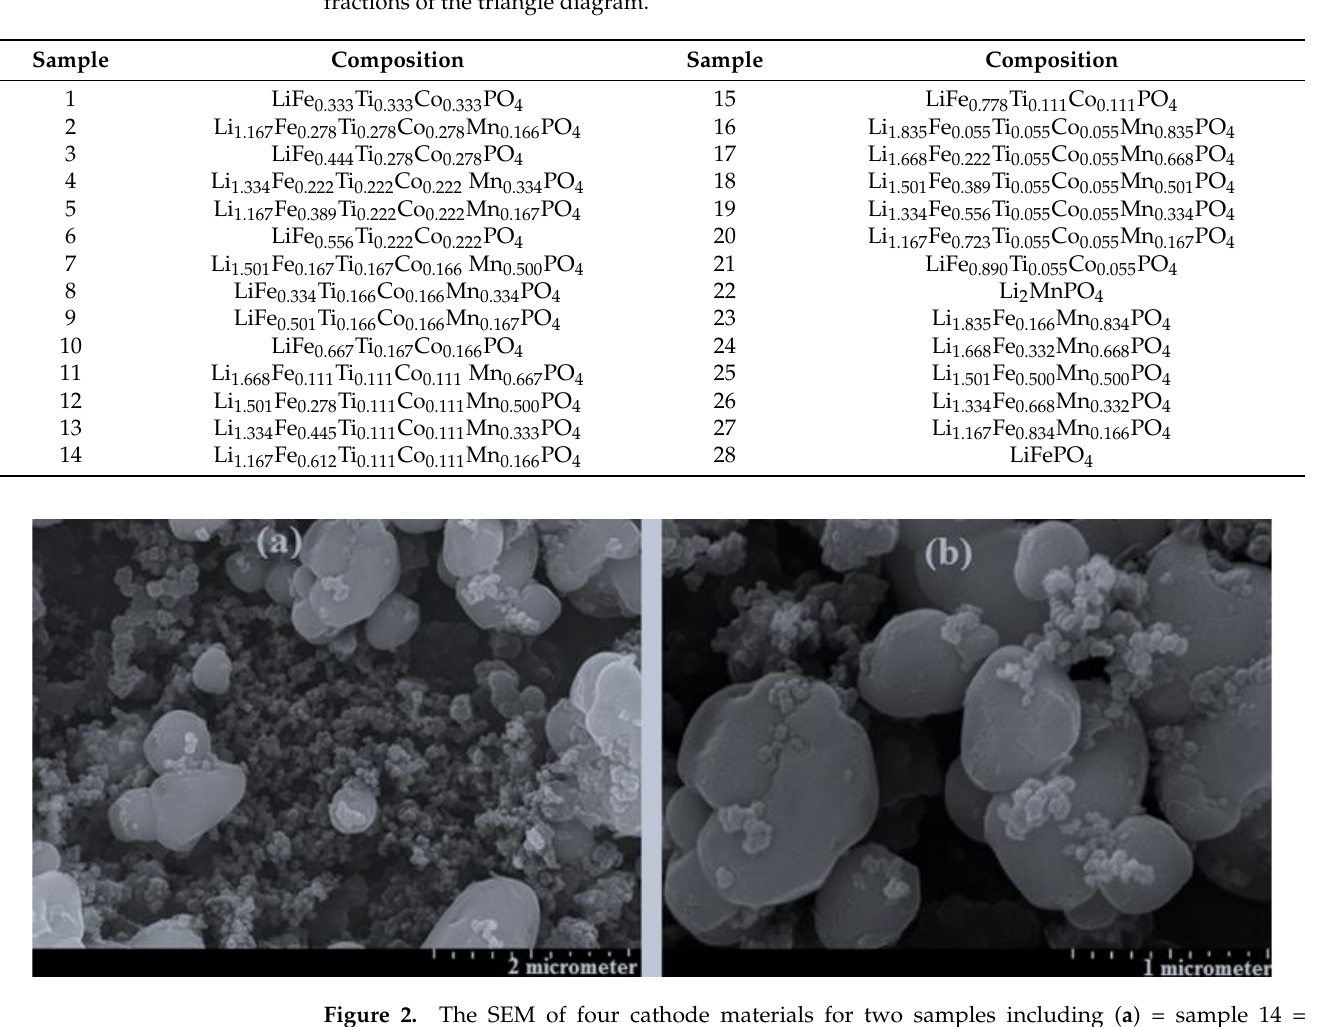
Figure 2. The SEM of four cathode materials for two samples including ( a ) = sample 14=